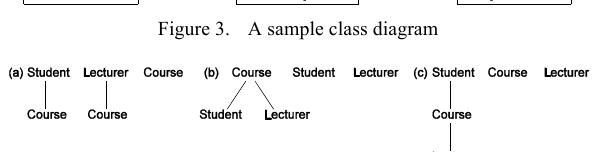
Figure 3. A sample class diagram